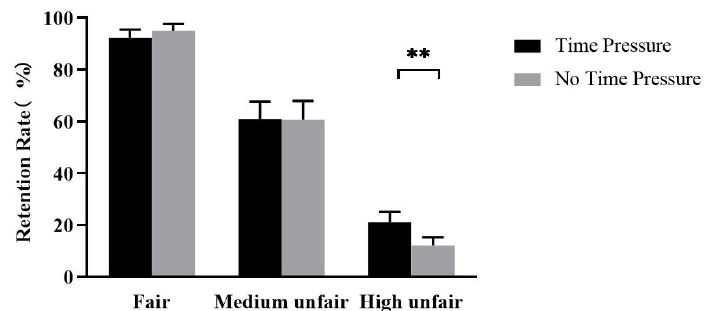
Figure 2. Histograms of the retention rates of different offers under time pressure and without time pressure (mean ± se). ** p < 0.01.